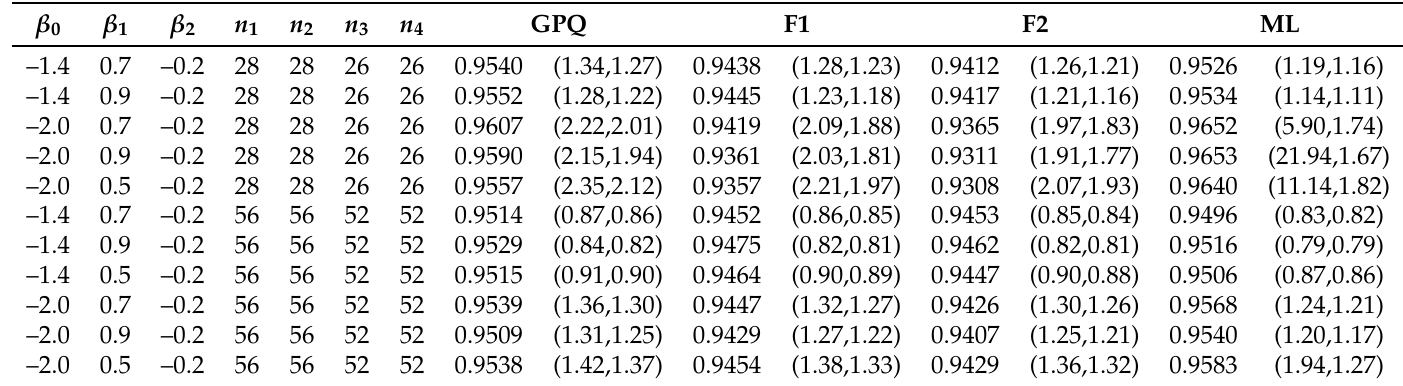
Table 2. Empirical coverage probability and (mean,median) length of different confidence intervals for the prevalence ratio in the log-binomial model mentioned in Section 4.2, for a 95% nominal